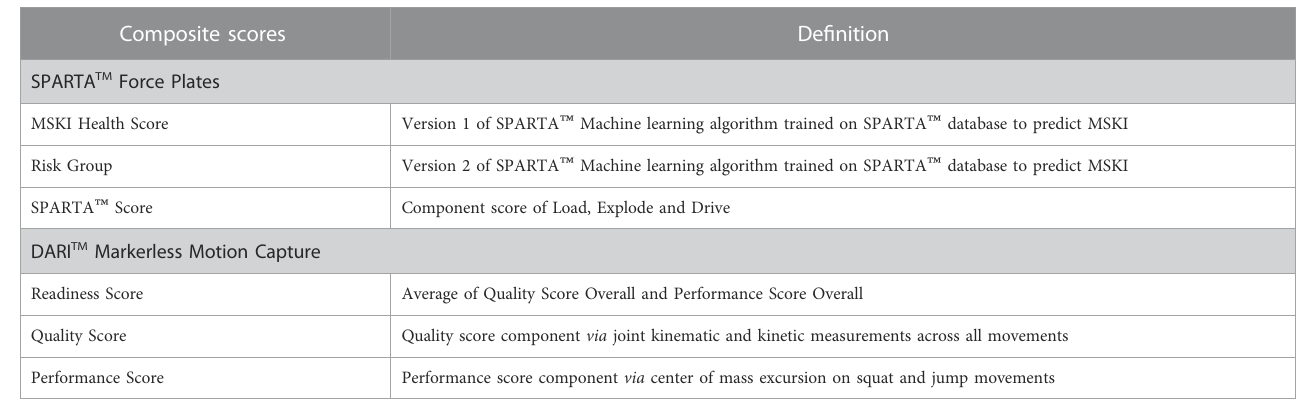
TABLE 1 De fi nitions of composite scores in DARI ™ and SPARTA ™